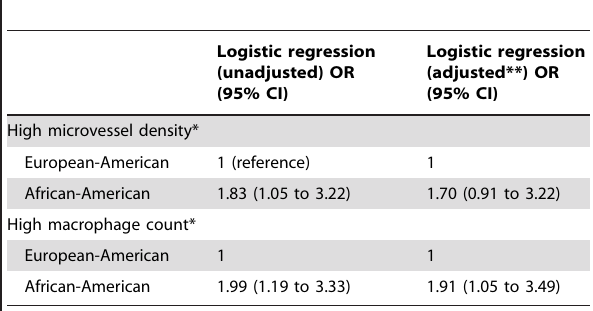
Table 6. Association of microvessel density and macrophage count with race/ethnicity of patients.